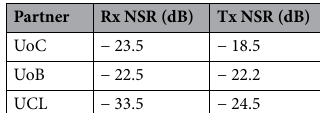
Table 4. Adjusted receiver NSR (dB) for each partner along with a typical transmitter NSR (dB).